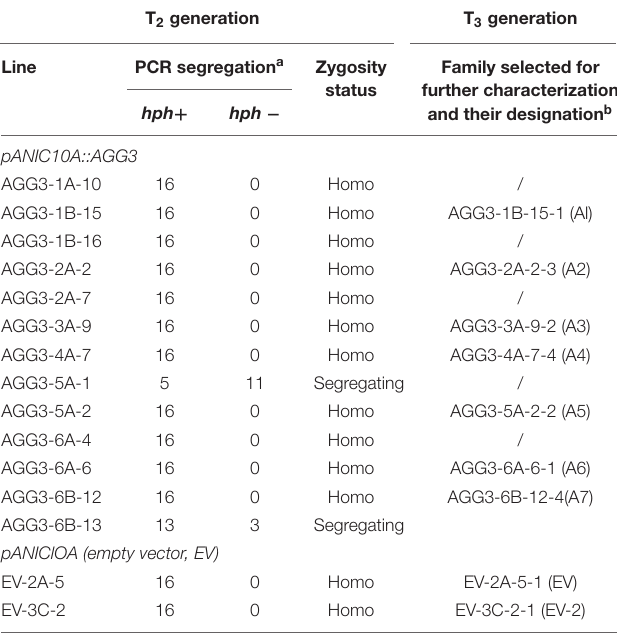
TABLE 2 | Genetic and molecular characterization of transgenic T 2 and T 3 S. viridis